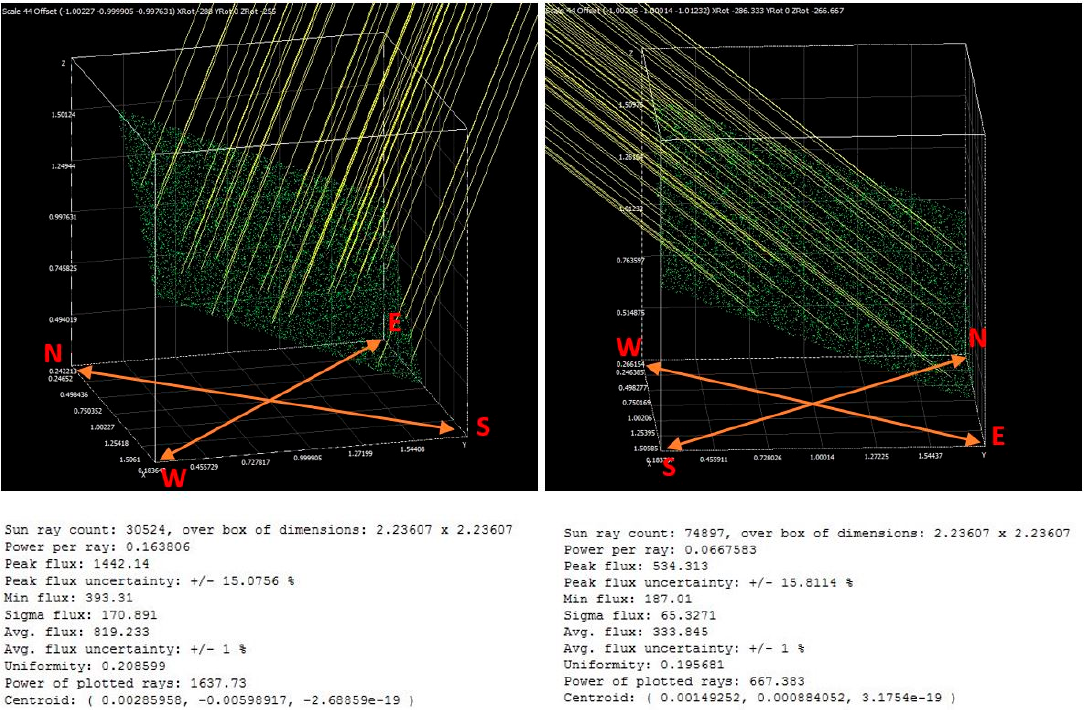
Figure 12. Tilting of the panel to the east at the noon.